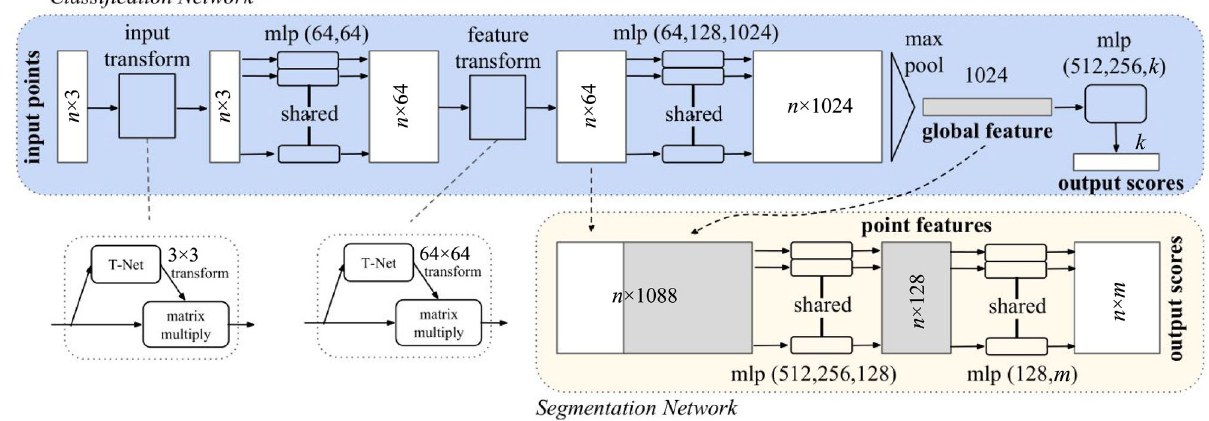
Fig. 2 Pipeline of PointNet . Reproduced with permission from Ref. [6], c (cid:2) IEEE